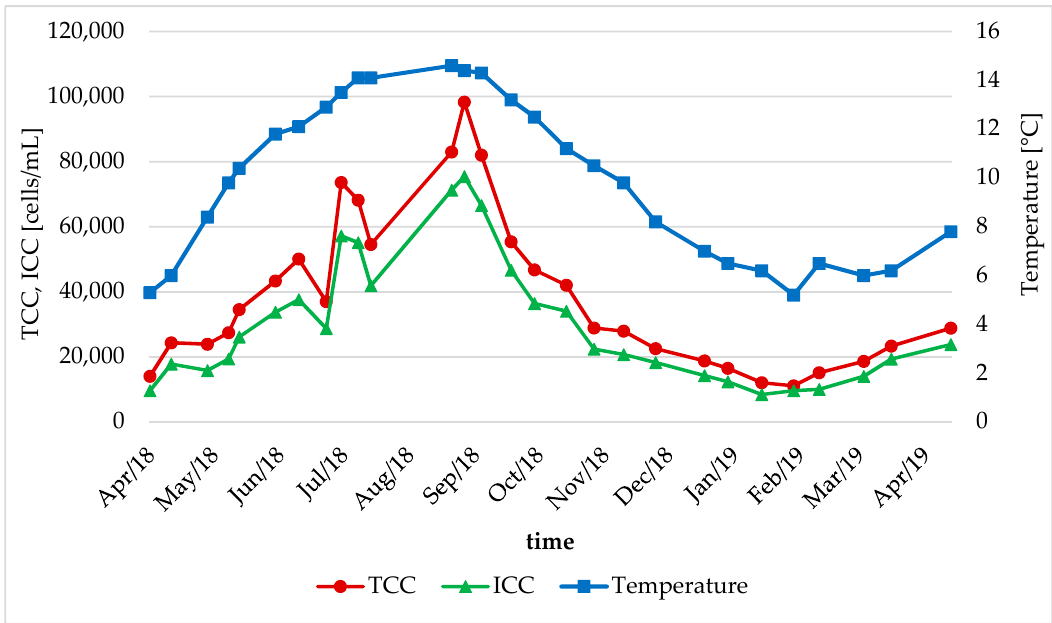
Figure 2. Changes in TCC (red line, circles), intact cell count (ICC) (green line, triangles), and water temperature (blue line; squares) at sampling point Masar. A clear seasonal trend, with increases in TCC and water temperature during the summer period, is shown.